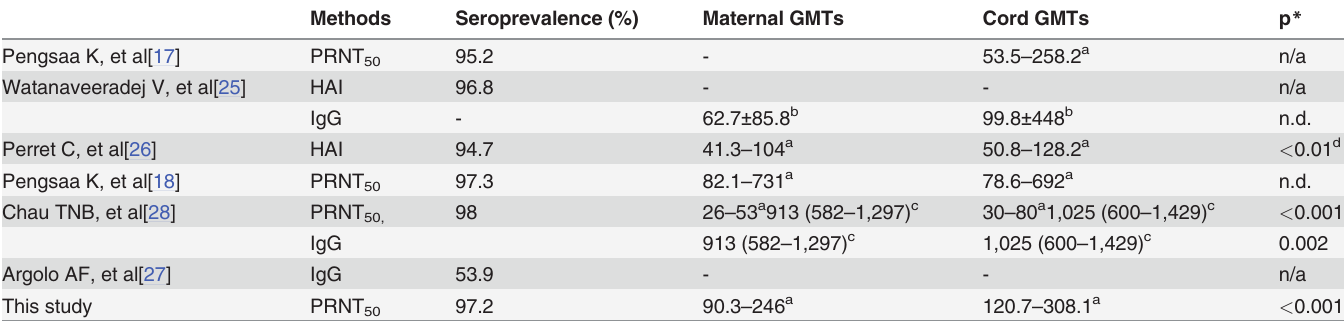
Table 3. Comparison of maternal dengue seroprevalence, maternal and cord sera dengue antibody titers in various articles.